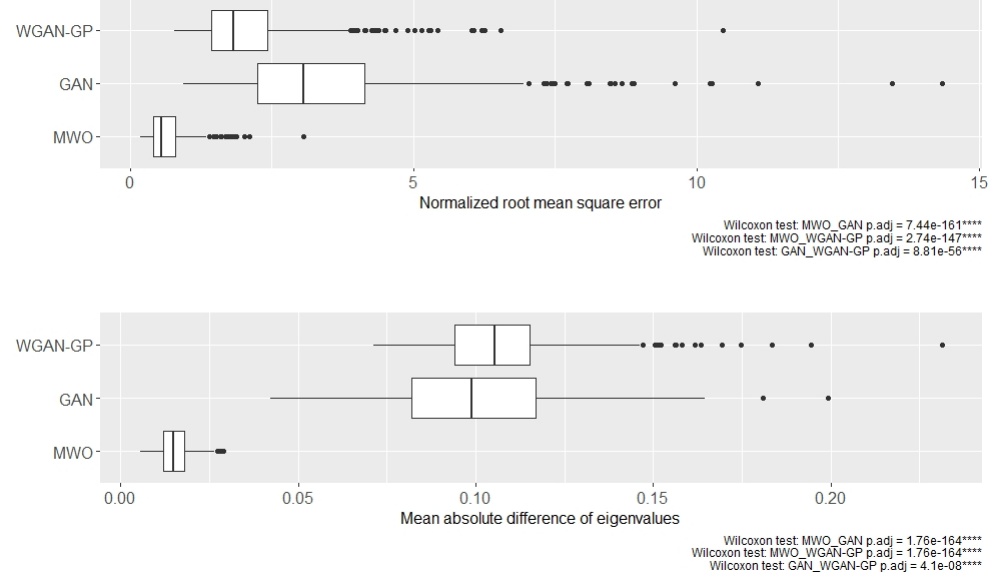
Figure 4. Distribution of normalized mean square errors ( top ) and mean absolute difference of eigenvalues ( bottom ) for microarray data when comparing the covariance matrices of artificial and original data. The boxplots represent data for 500 runs, in each of which 50 genes were randomly drawn and the correlation matrices were created. The symbol **** denotes p -value <